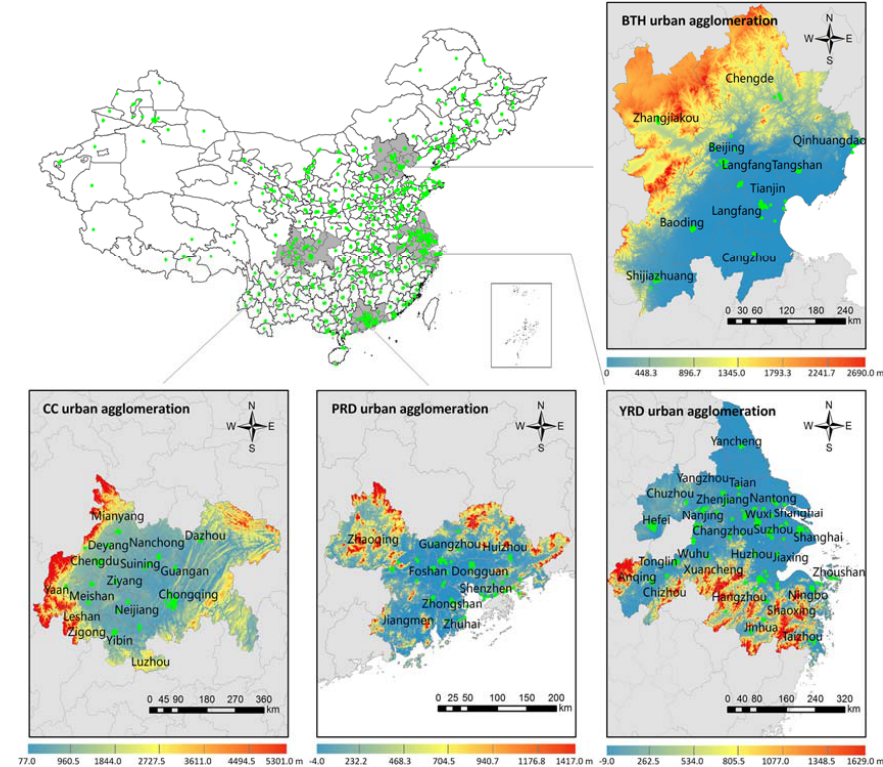
Figure 1. The location of the study areas and stations for PM 2.5 monitoring. The color scale represents the elevation variability across the urban agglomeration.